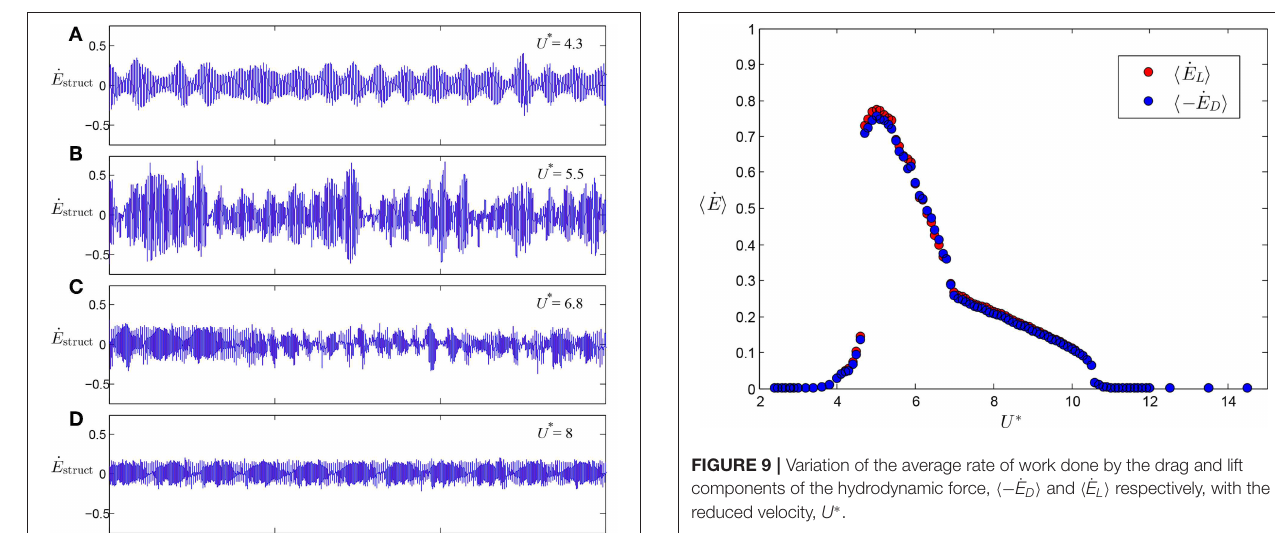
and h˙ E L respectively, with the i i